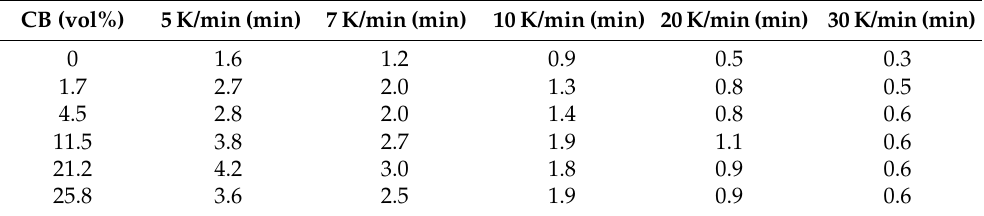
Table 6. Half times t 1/2 of the EVA20/GNP composites’ crystallisation process at different tempera- ture gradients. The pure EVA20 noted as 0 vol% is displayed for comparison. GNP (vol%)